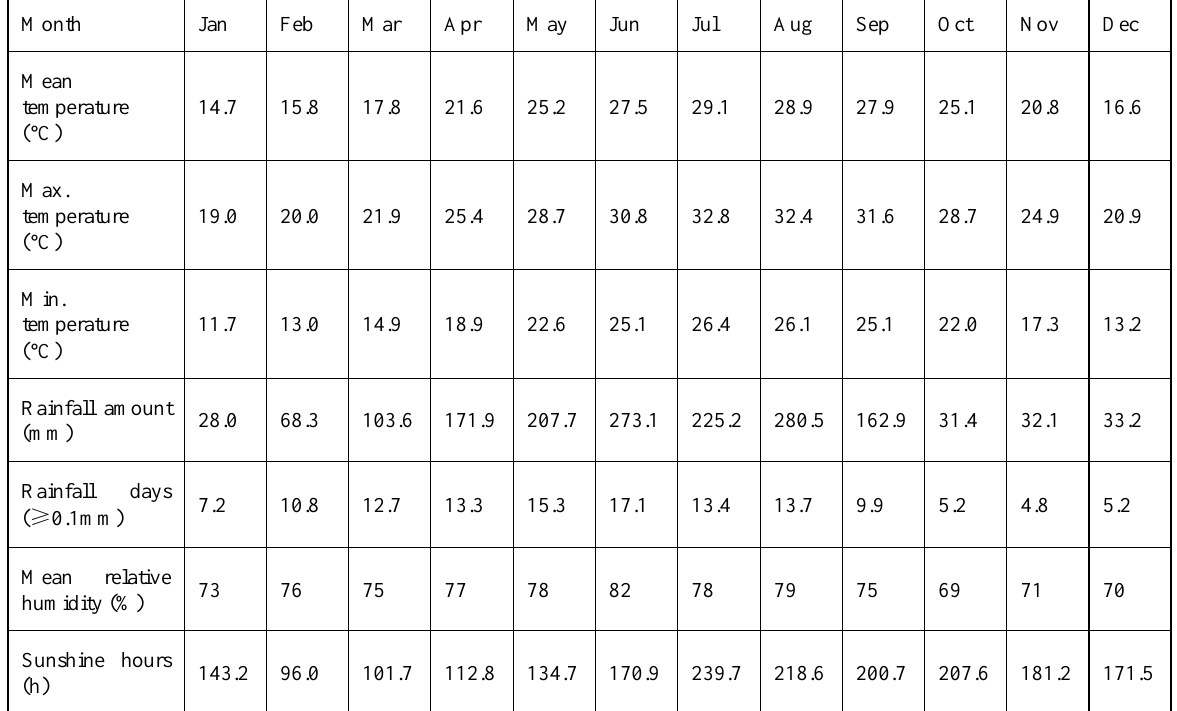
Table 1 Average climate data in Shantou from 1981 to